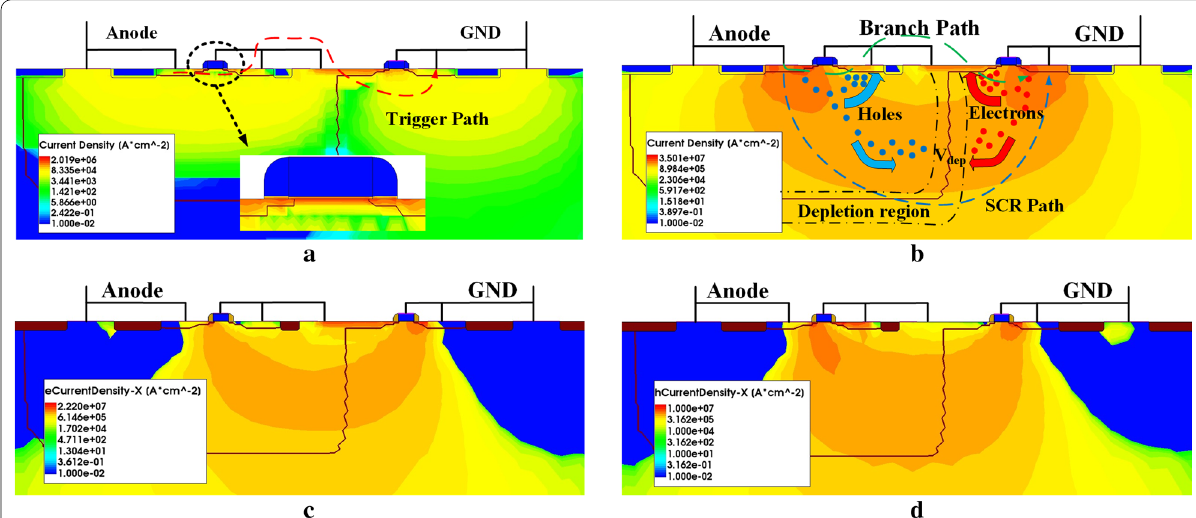
Fig. 2 TCAD-simulated a total current density distribution at t 500 ps, b total current density distribution at 5 ns, c horizontal electrons current = density distribution at 5 ns and d horizontal holes current density distribution at 5 ns of the proposed EP-LVTSCR under a 1.2A-TLP stress